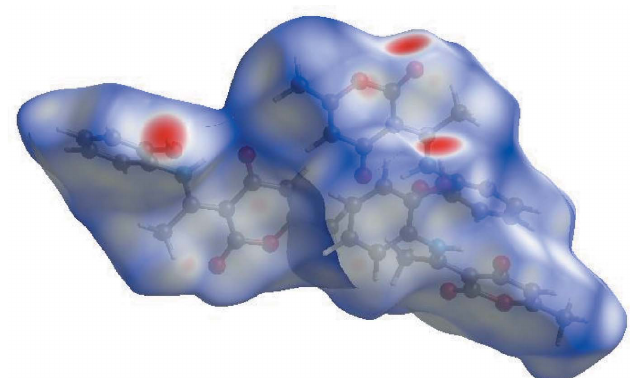
Figure 4 View of the three-dimensional Hirshfeld surface of the title compound, plotted over d norm in the range (cid:5) 0.7208 to 1.5611 a.u.